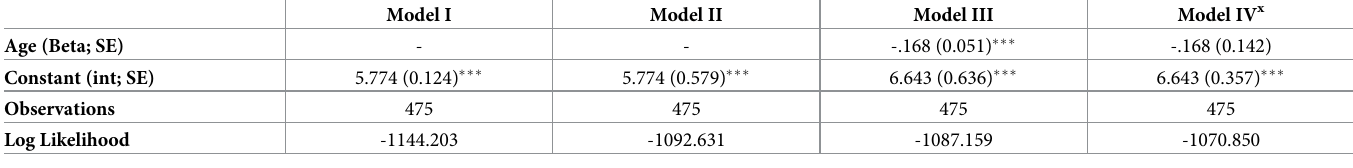
Table 4. Results of iterative regression models for determining hierarchy of